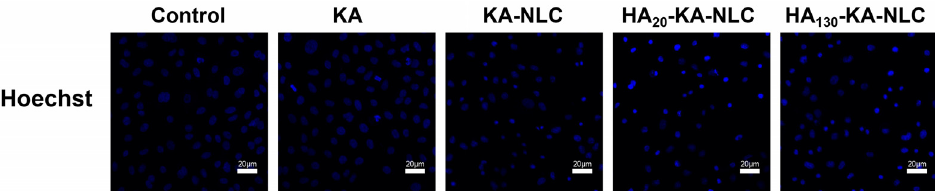
Figure 12. Cellular apoptosis assay conducted on A549 cells without treatment or with KA, KA-NLC, HA 20 -KA-NLC, and HA 130 -KA-NLC treatments.